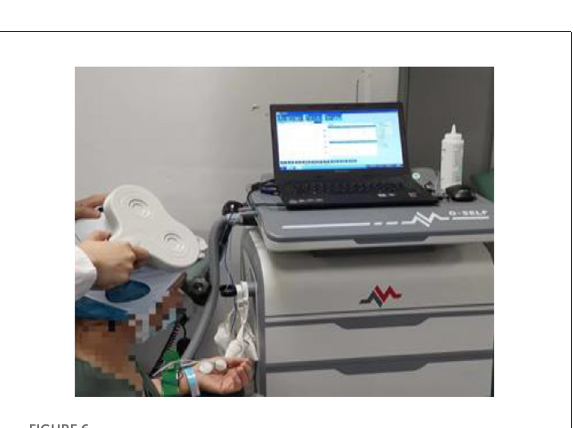
and baseline scores between the different groups. ( P > 0.05) (Table 1). When comparing within groups, the FMA-UE scores of the three groups before and after treatment were statistically